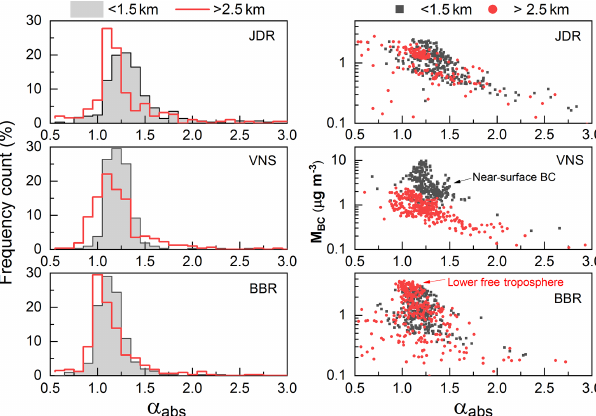
Figure 14. (a) Frequency of occurrences of absorption Ångström exponent ( α abs ) below 1.5km and above 2.5km altitude; (b) varia- tion in BC mass concentrations corresponding to different values of α abs is shown in the right panels for the same two altitude regimes at distinct locations of northern